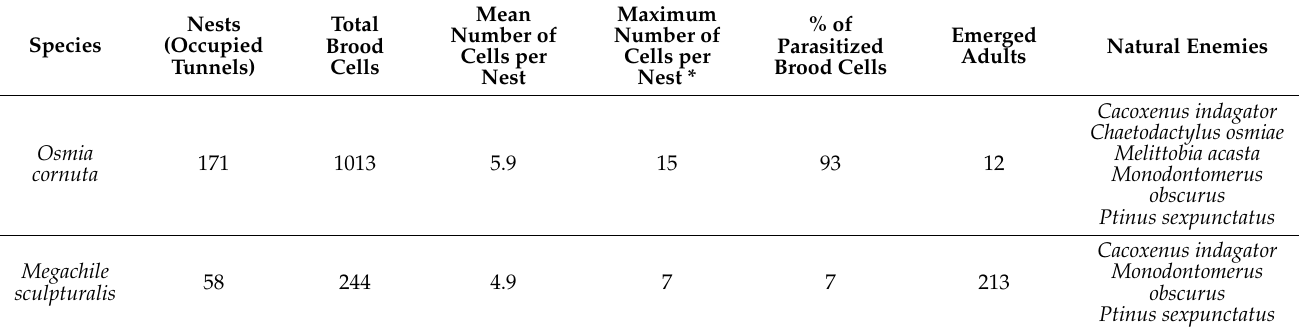
Table 1. Cavity-nesting bees and their natural enemies in trap nests.